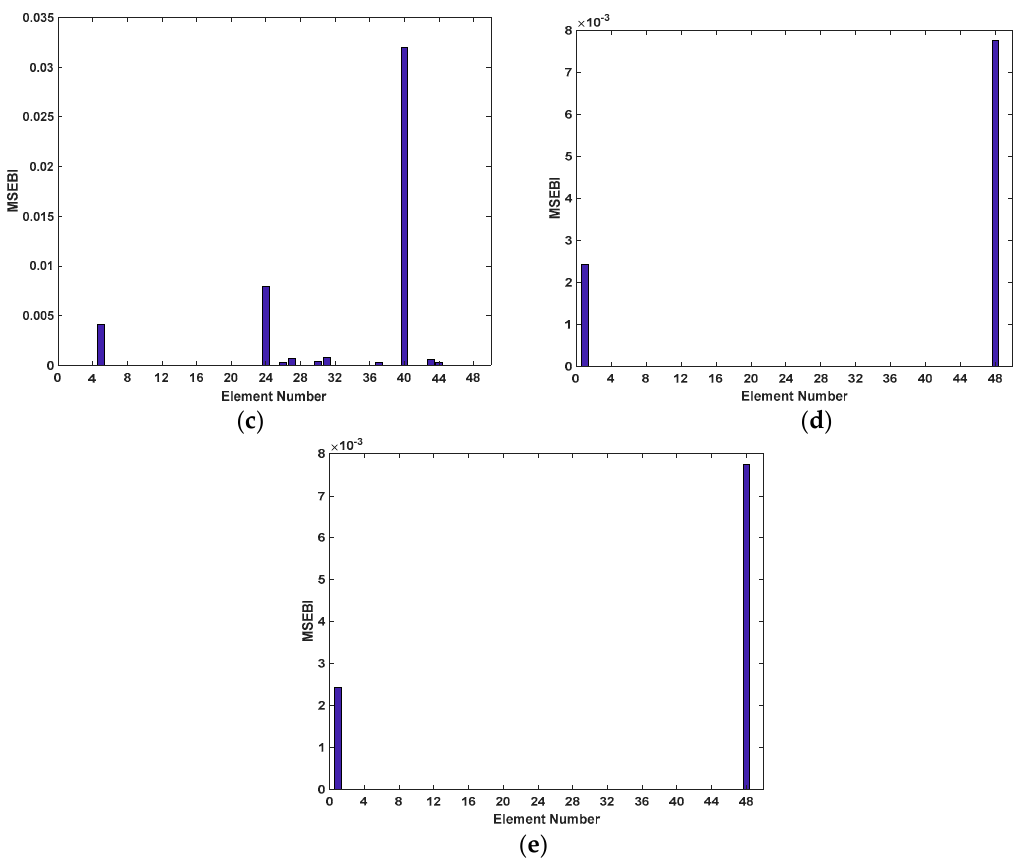
Figure 6. Results of structural elements damage location: ( a ) Case 1; ( b ) Case 2; ( c ) Case 3; ( d ) Case 4; and ( e ) Case 5.